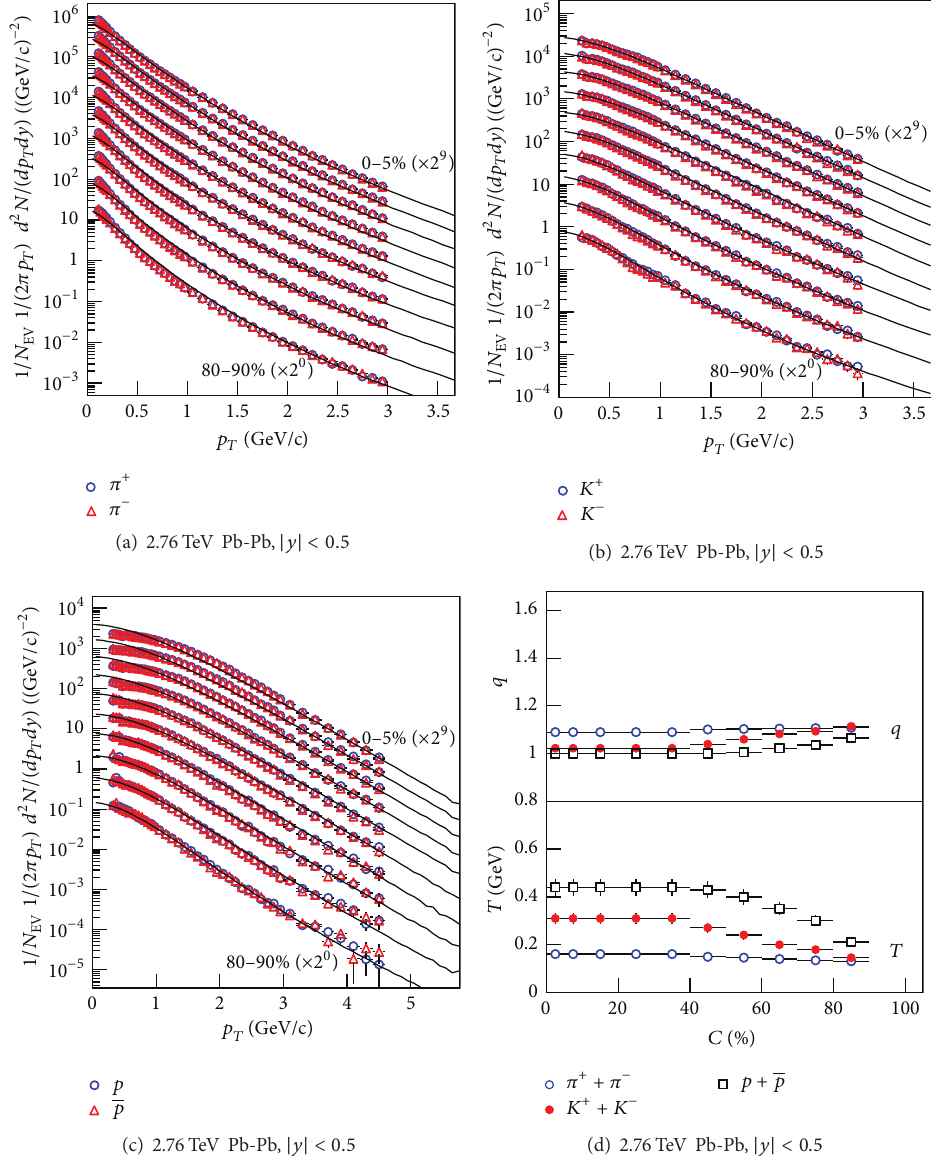
Figure 1: (a)–(c) Transverse momentum distributions of (a) 𝜋 + + 𝜋 − , (b) 𝐾 + + 𝐾 − , and (c) 𝑝 + 𝑝 produced in Pb-Pb collisions at √𝑠 𝑁𝑁 = 2.76 TeV in different centrality intervals 0–5%, 5–10%, 10–20%, ... , and 80–90% scaled by multiplying 2 9 , 2 8 , 2 7 , ... , and 2 0 , respectively. The symbols represent the experimental data of the ALICE Collaboration [8] and the curves are results of the Tsallis statistics. (d) Dependences of parameters 𝑇 and 𝑞 on centrality intervals. Different symbols represent the parameter values extracted from the distributions of different charged